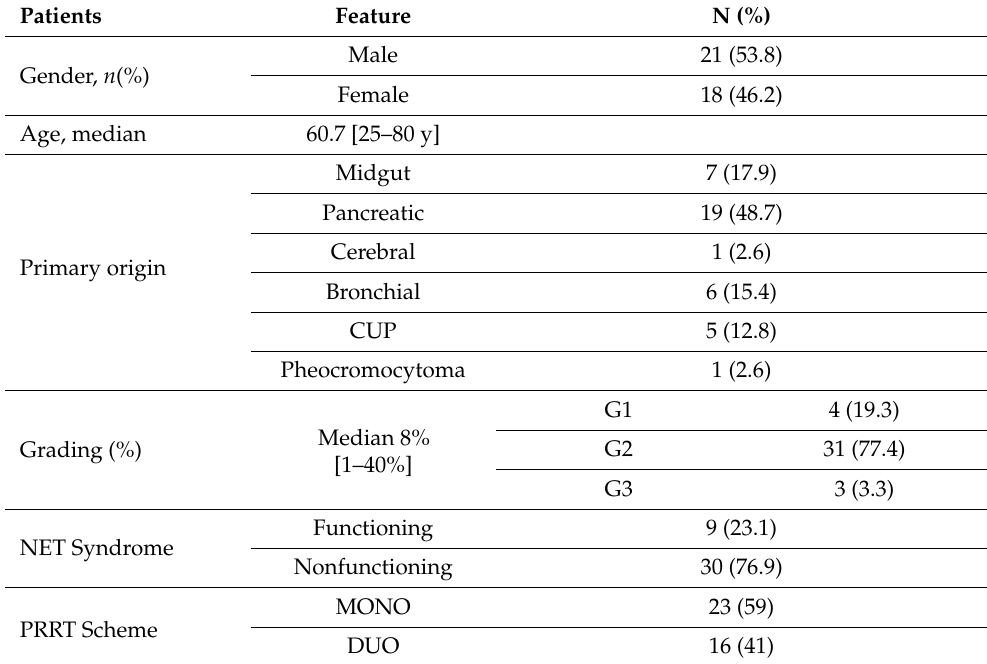
Table 1. Patients’